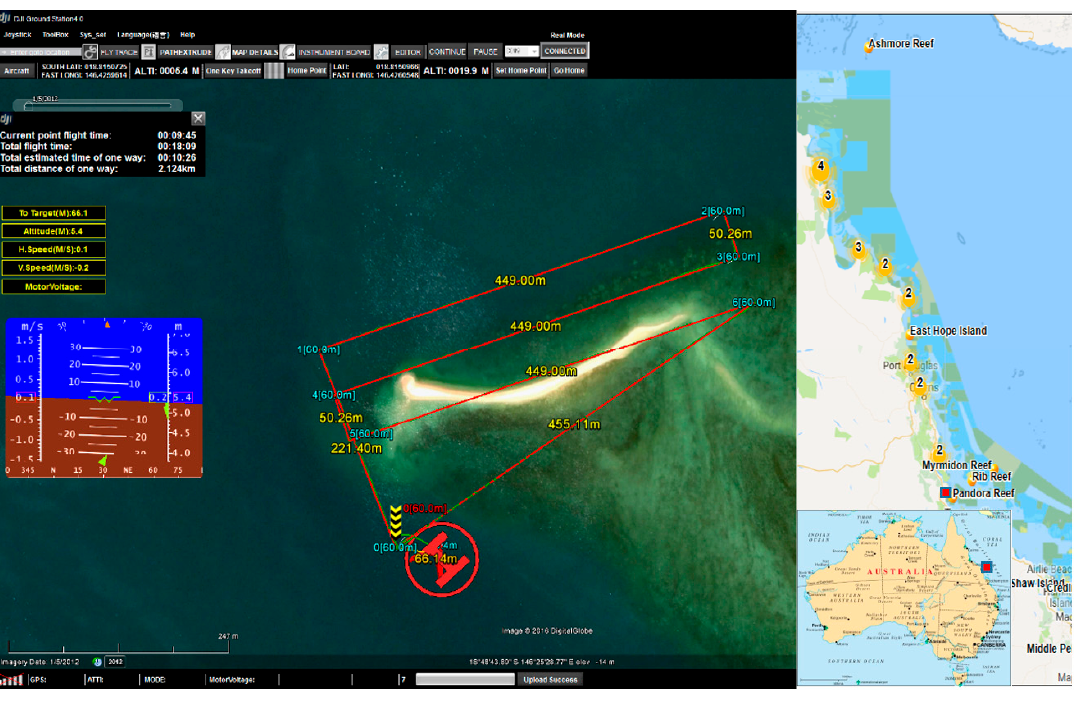
Figure 13. Numbered in-water survey GPS coordinates at Pandora Reef shown through Google Earth.